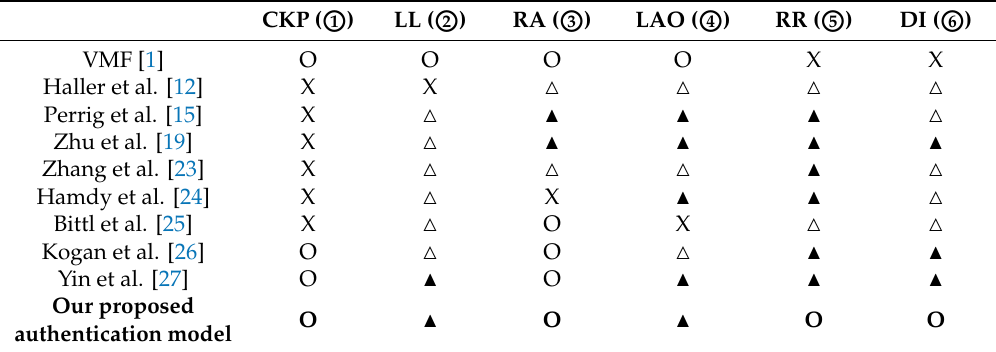
Table 9. Taxonomy of existing LSH hash chain-based authentication and proposed